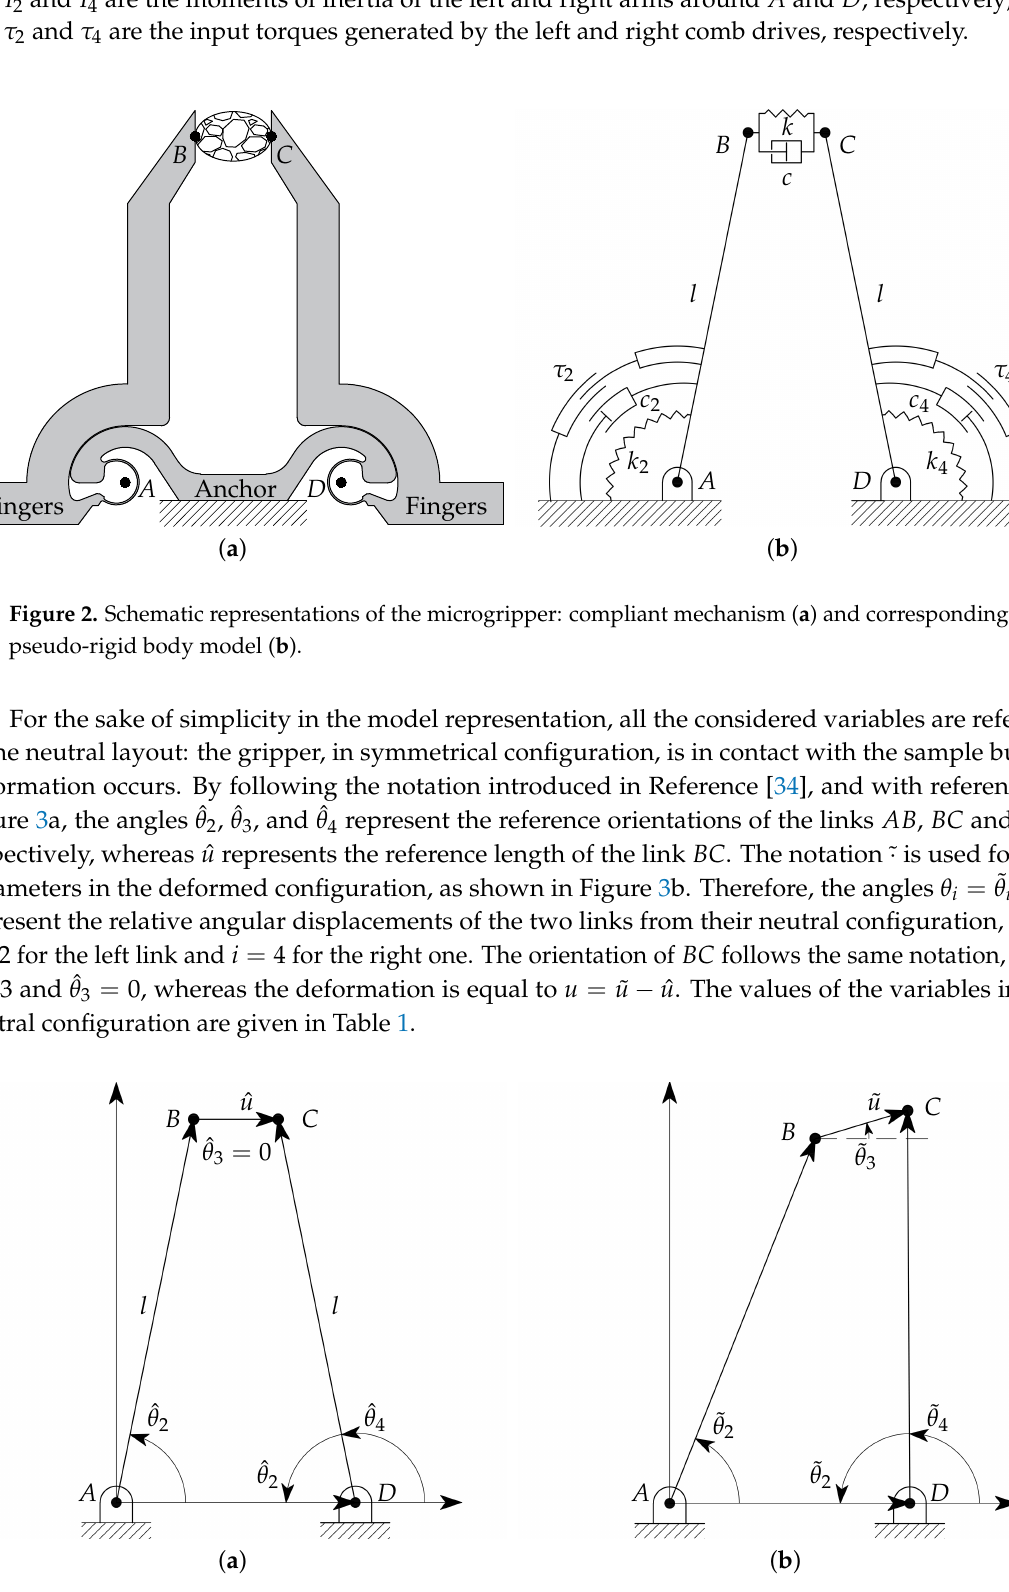
Figure 3. Nomenclature and model parameters in neutral ( a ) and general ( b )